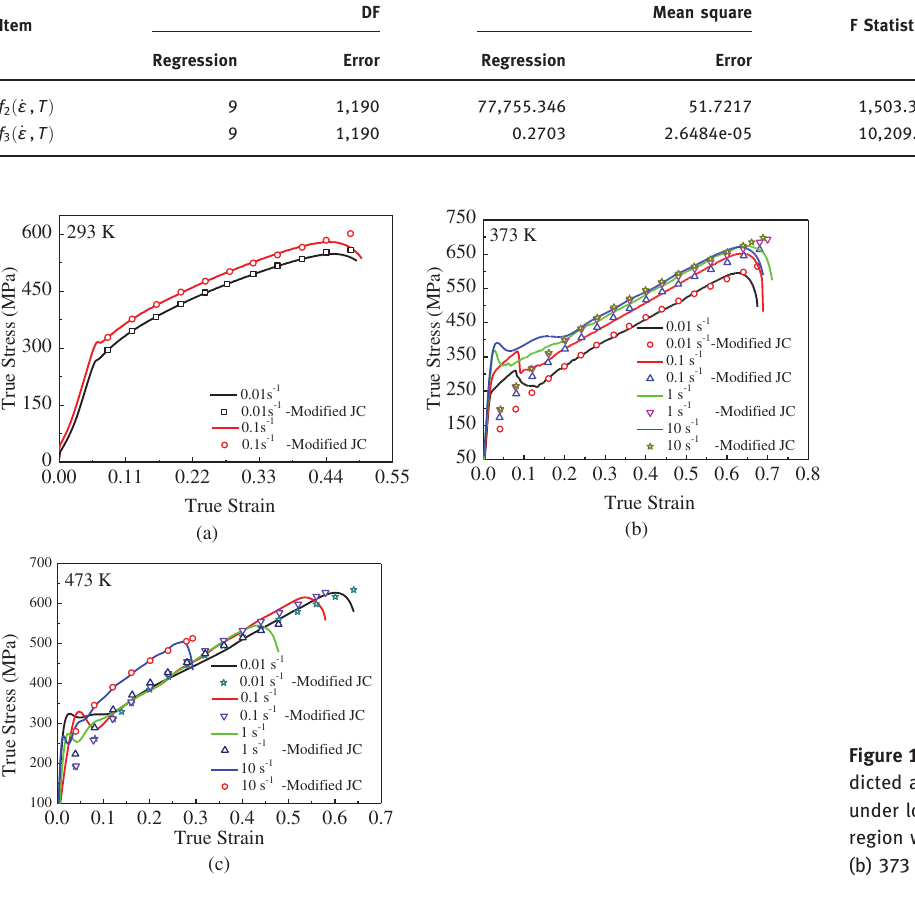
F Statistic P>F Adj. R 